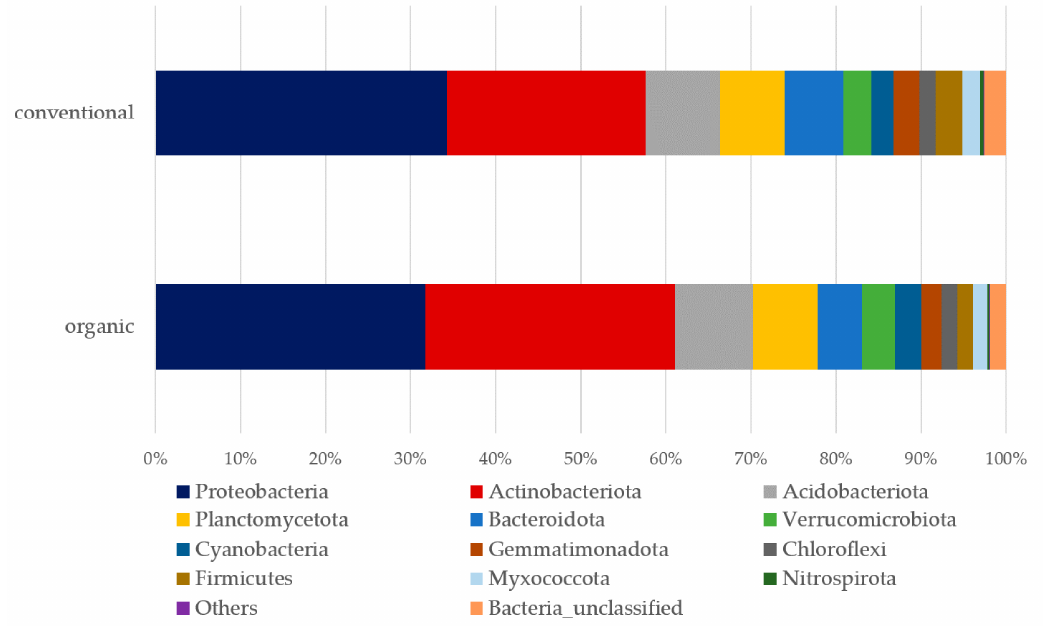
Figure 1. Relative abundance of soil bacteria in conventional and organic vineyards. On closer analysis, we detected some differences at the family level, and the LefSe analysis showed that four families, Micrococcaceae, Azospirillaceae, Oxalobacteraceae and Rubrobacteriaceae were mainly responsible for the differences between managements (Figure 2A). At the genus level, Massilia , Arthrobacter and Rubrobacter showed an interesting abundance distribution pattern following, from higher to lower abundance, the gradient: herbicide + tillage > mowing only > mowing + tillage (Figure 2B). Sphingomonas , Microvirga and unclassified_Actinobacteriota were higher under organic farming with mowing as cover crop